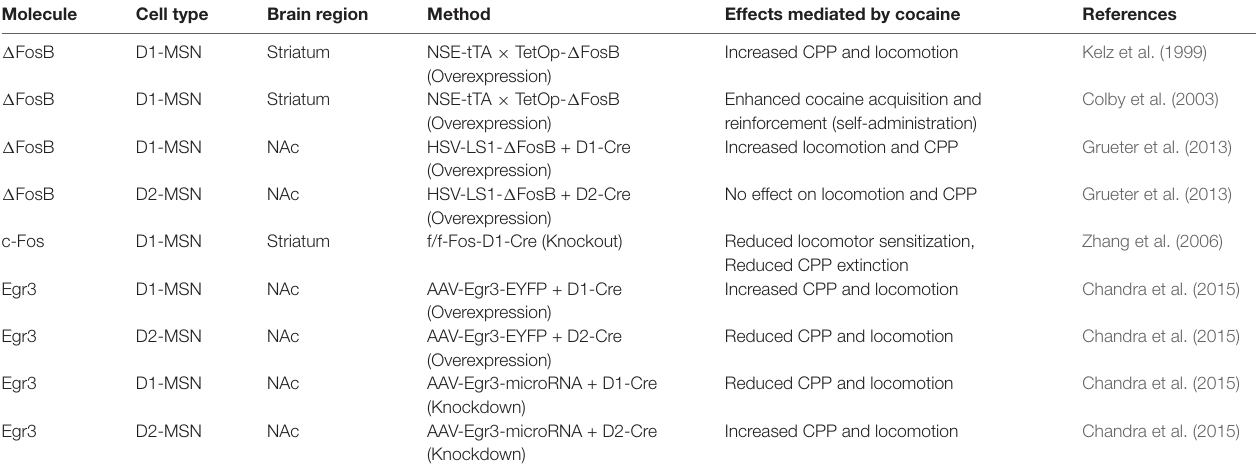
TABLE 1 | Medium spiny neuron (MSN) subtype manipulation of Immediate early genes (IEGs) in cocaine behaviors.